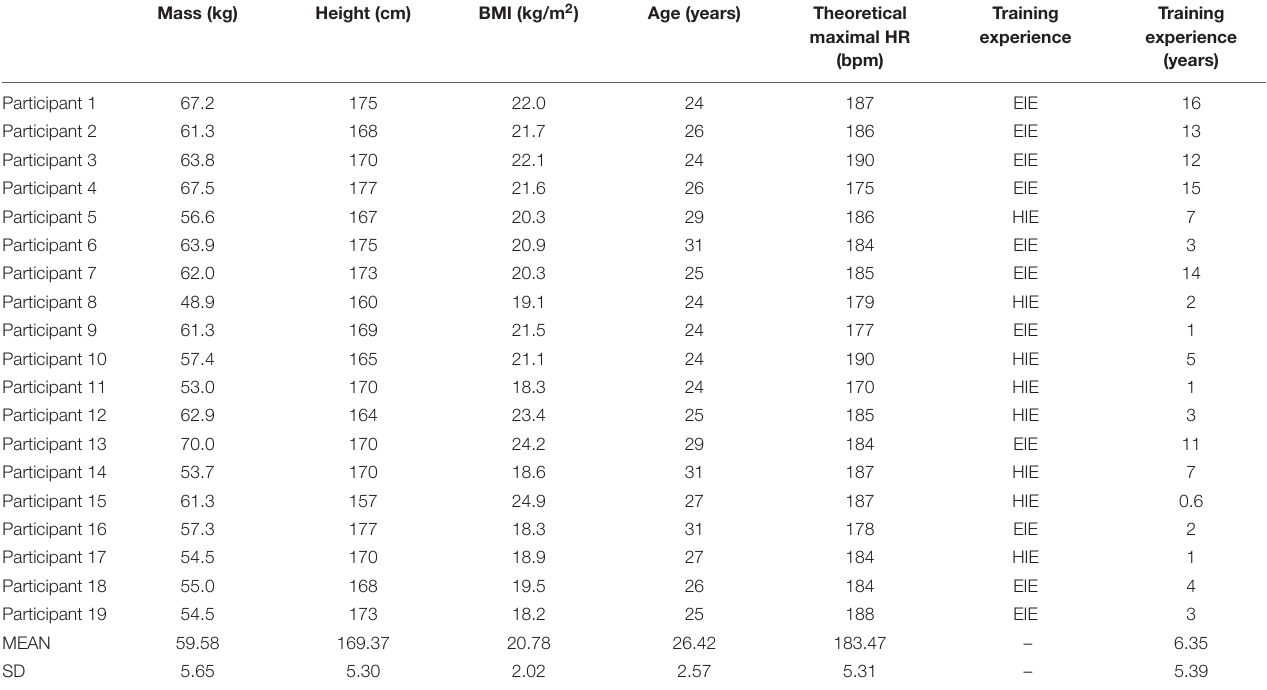
TABLE 1 | Characteristics of participants.